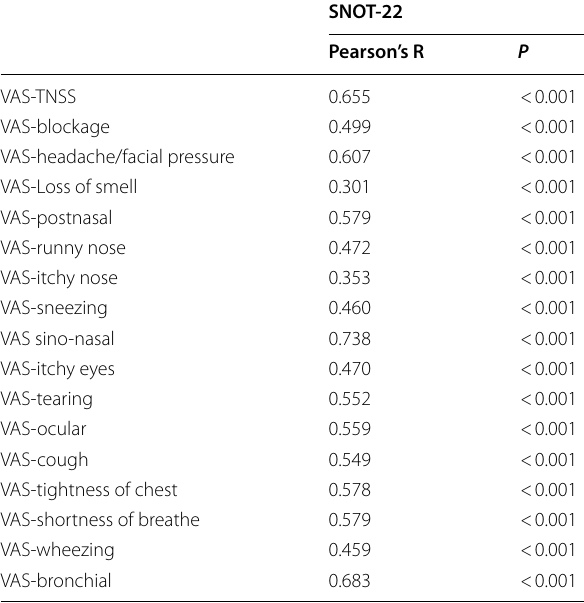
Table 2 Pearson’s correlation of SNOT-22 score with VAS scores in CRS